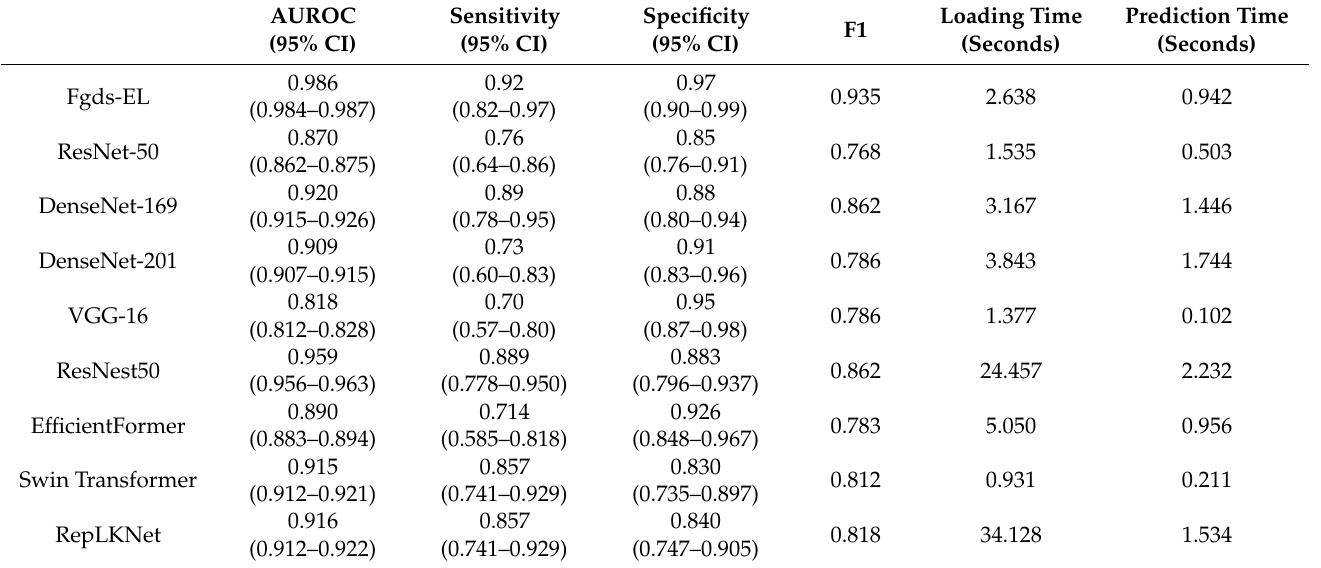
Table 3. Performance of four deep learning algorithms in the test